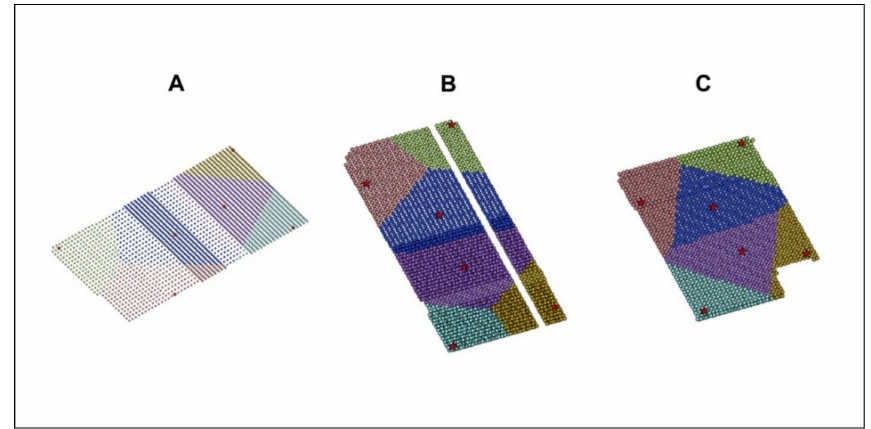
Figure 3. Graphic representation on the map of the TrapAreas in blocks A, B, and C as output when the number of the traps with new captures are < 1 / 3 of the number of the traps of the plot, as defined by DSS2. Red stars identify the position of the monitoring traps in the field. Each colour defines the TrapArea around a